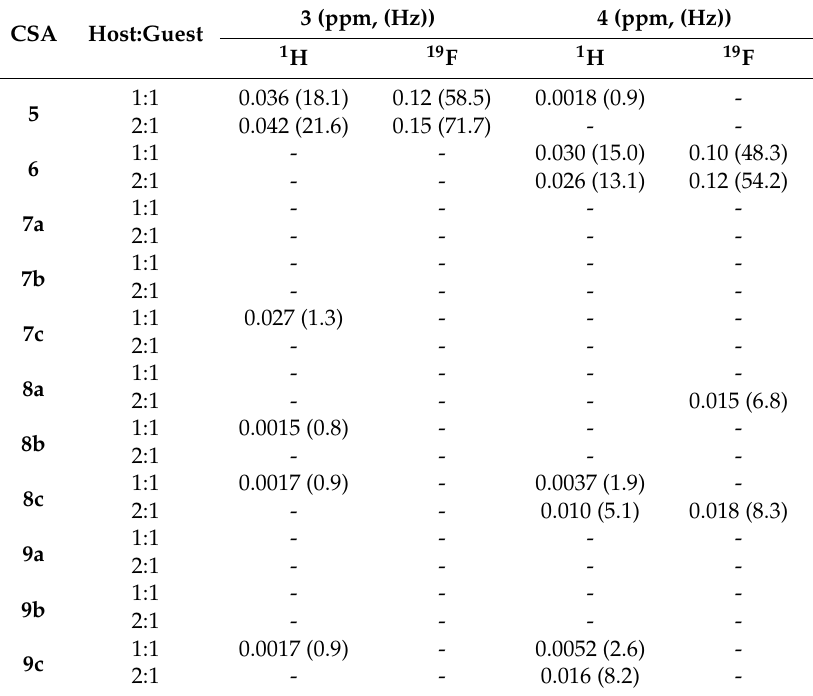
Table 2. Determination of the magnitude of non-equivalence ( ∆ δ ) with 3 and 4 as model compounds in the presence of different 2 -based CSAs, using both 1 H (500 MHz) and 19 F-NMR (470 MHz) in CDCl 3 at 27 ˝ C (-indicates resolution not